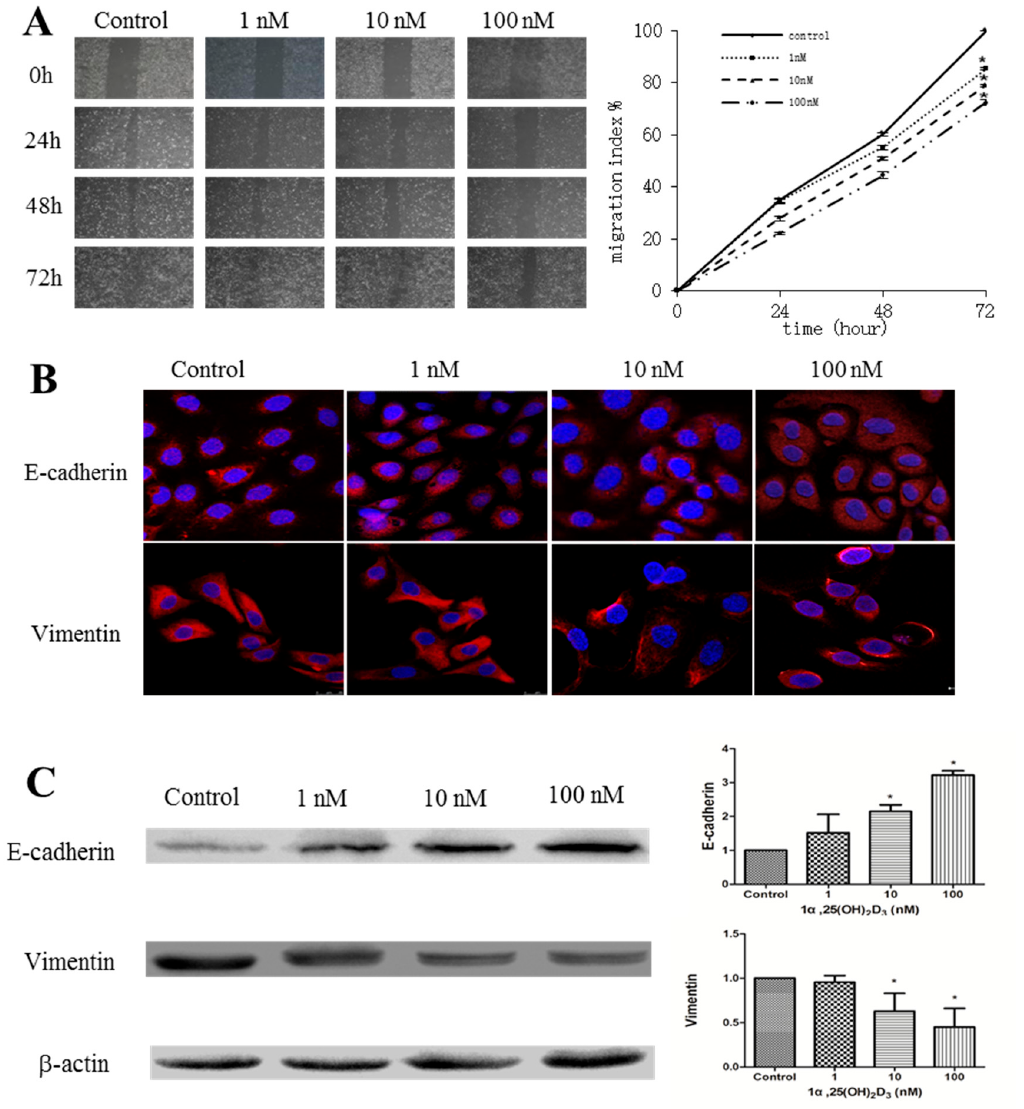
Figure 1. 1 α ,25(OH) 2 D 3 inhibited the migration of human ovarian adenocarcinoma cell line SKOV-3 cells. ( A ) Left : representative pictures of the wound area obtained 24, 48 and 72 h after scratching. 100× magnification; Right : migration index (%) = [(the initialized width of the scratch) − (the final width of the scratch)]/(the initialized width of the scratch); ( B ) representative pictures of E-cadherin and Vimentin were captured by confocal laser scanner microscopy (CLSM) 24 h after being treated with 1 α ,25(OH) 2 D 3 . Nuclear DNA was visualized by 4 ′ ,6-diamidino-2-phenylindole (DAPI) staining. 200× magnification; ( C ) Left : Western blot analysis of the indicated proteins in SKOV-3 cells. β -actin served as a loading control; Right : the level of the indicated protein was quantified with gray value. The data represent the Mean ± SD. * p < 0.05 versus control.